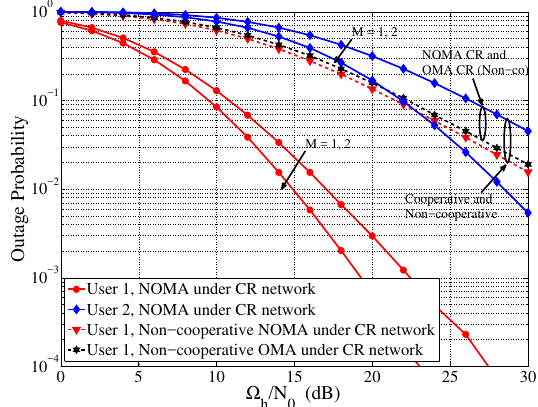
Figure 2. Outage probability of cooperative NOMA under CR network. Simulation parameters are as follows: the number of antennas at the BS, M = 1 , 2 , the power allocation parameters, | a | 2 = 0 . 8 , | a | 2 = 0 . 2 , the target SINRs, γ 1 2 transmit power at the primary transmitter, P P = 5 dB, the maximum allowable transmit power at the BS, P Max maximum tolerable interference power at the primary transmitter, I P = 10